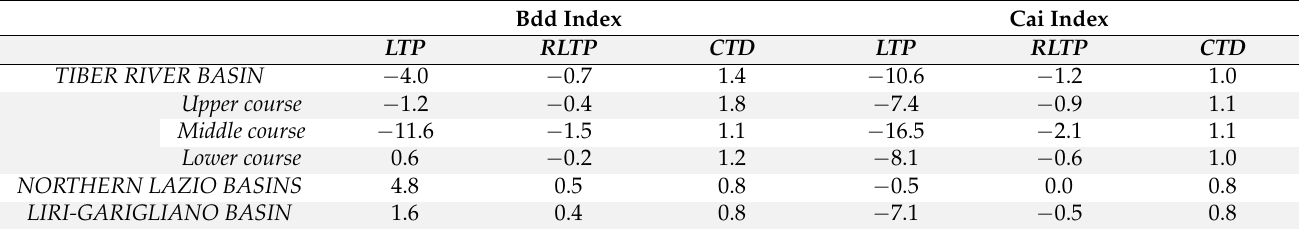
Table 5. Timing scores of BDD and CAI